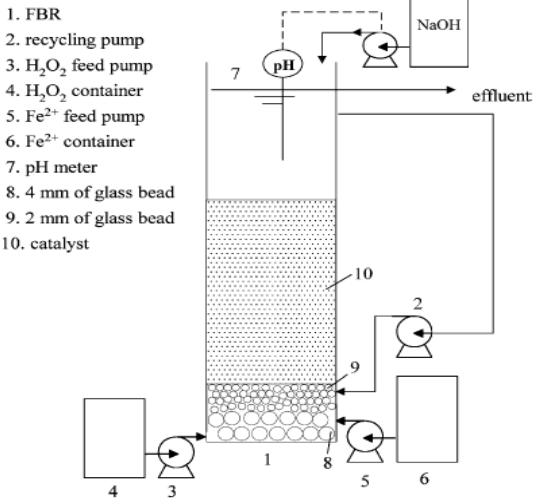
Figure 1. Schematic diagram of catalytic support synthesis device.